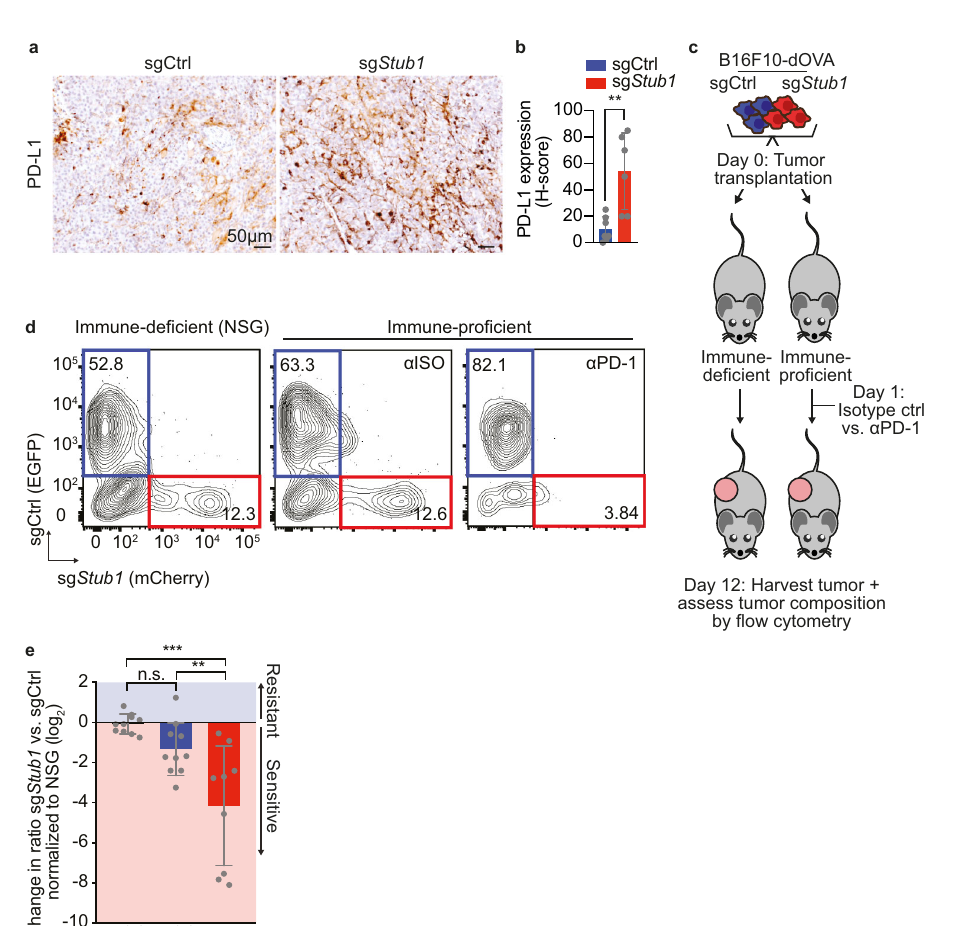
Fig. 4 STUB1 inactivation sensitizes melanoma cells to cytotoxic T cells through ampli fi ed IFN γ signaling. a Immunoblots of D10 cells expressing sgCtrl or sg STUB1 , treated with a two-fold serial dilution of IFN γ (starting at 50 ng/ml) for 30 min. Same protein amounts were loaded on two separate gels, whole cell lysates (WCL) were immunoblotted for indicated proteins (TUB is tubulin) and developed simultaneously. Same exposure for the blots is shown. Representative of three biological replicates. b Immunoblot of D10 cells expressing sgCtrl or sg STUB1 , treated with vehicle or 50 ng/ml IFN γ for the indicated duration. WCL were immunoblotted for the indicated proteins. (TUB is tubulin, pSTAT1 is pY701). Representative of three biological replicates. c qPCR analysis of CD274 (encoding PD-L1) expression in D10 cells expressing sgCtrl or sg STUB1 , after treatment with vehicle or 25 ng/ml IFN γ for the indicated duration. d , e Gene set enrichment analysis on RNA sequencing results for D10 and SK-MEL-147 melanoma cells co-cultured with MART-1 T cells for 8 h (from Supplementary Fig 4d). d IFN-related pathways. e TNF-related pathways. f Colony formation assay of D10 cells expressing sgCtrl or sg STUB1 treated with vehicle or 3 ng/ml IFN γ for 5 days. g Quanti fi cation of colony formation assay in f . h Colony formation assay of D10 cells expressing sgCtrl or sg STUB1 treated with no or MART-1 T cells for 24 h and subsequent culture for 4 days. i Quanti fi cation of colony formation assay in h . j Colony formation assay of D10 cells expressing indicated sgRNAs, which were co-cultured with no or MART-1 T cells at T cell: melanoma cell ratios 1:16, 1:8 and 1:4 (left to right) for 24 h and stained 4 days later. k Quanti fi cation from j at a T cell: melanoma cell ratio of 1:8. l Spearman correlation of STUB1 gene expression with the Hallmark IFN γ response gene set expression in patients tumors 12 , n = 31; only anti-PD-1 on-treatment samples were included. Mean ± SD in c , ** p = 0.0064, * p = 0.033, multiple t -tests for three biological replicates. Mean± SD in g , i , ordinary one-way ANOVA for three biological replicates with Tukey post hoc testing. **** p < 0.0001. Mean± SD in k , **** p < 0.0001, n.s. p = 0.1226, ordinary one-way ANOVA for four biological replicates with Tukey post hoc testing.